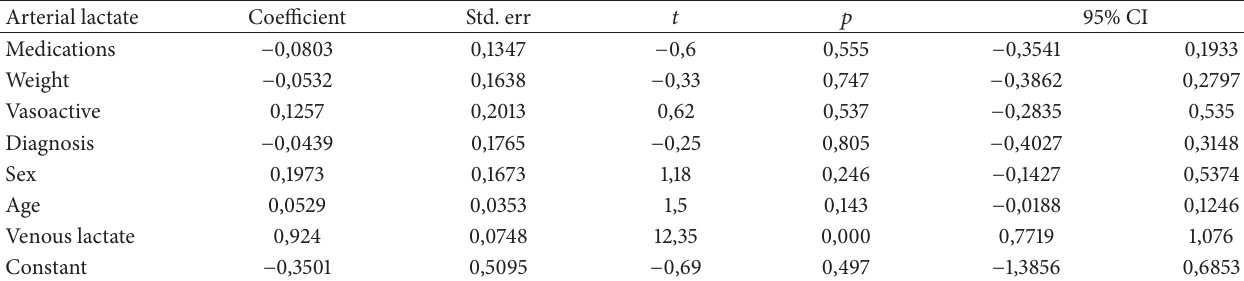
Table 4: Nonparametric regression model. Model description of relationship between arterial and venous lactate factors that may affect the